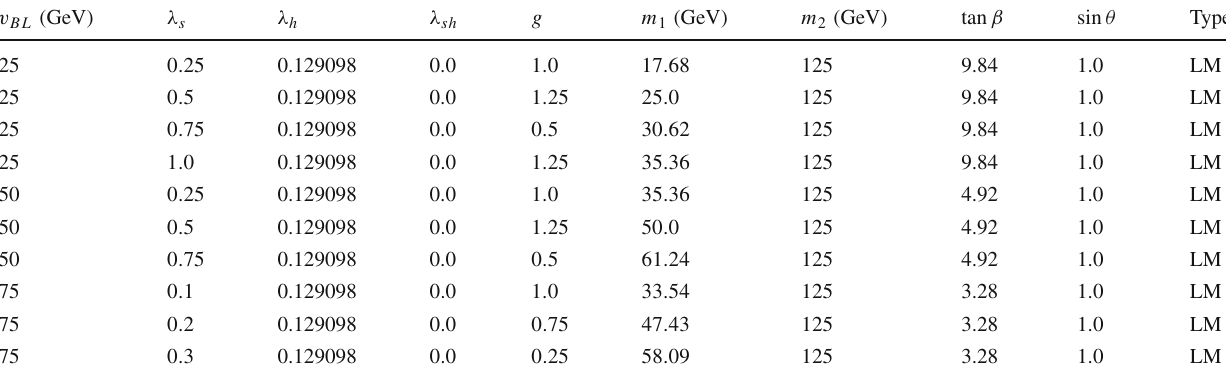
Fig. 5 Gravitational wave signals from the model parameters with v ≥ v = 246 GeV, compared with the detectability of future BL e w spatial interferometers. The benchmark scales are taken v BL = 246 GeV , 500 GeV , 750 GeV , 1000 GeV, with the string notation Table 1 Part parameters in Fig. 4. Here we have set λ h = m 2 HM: high mass